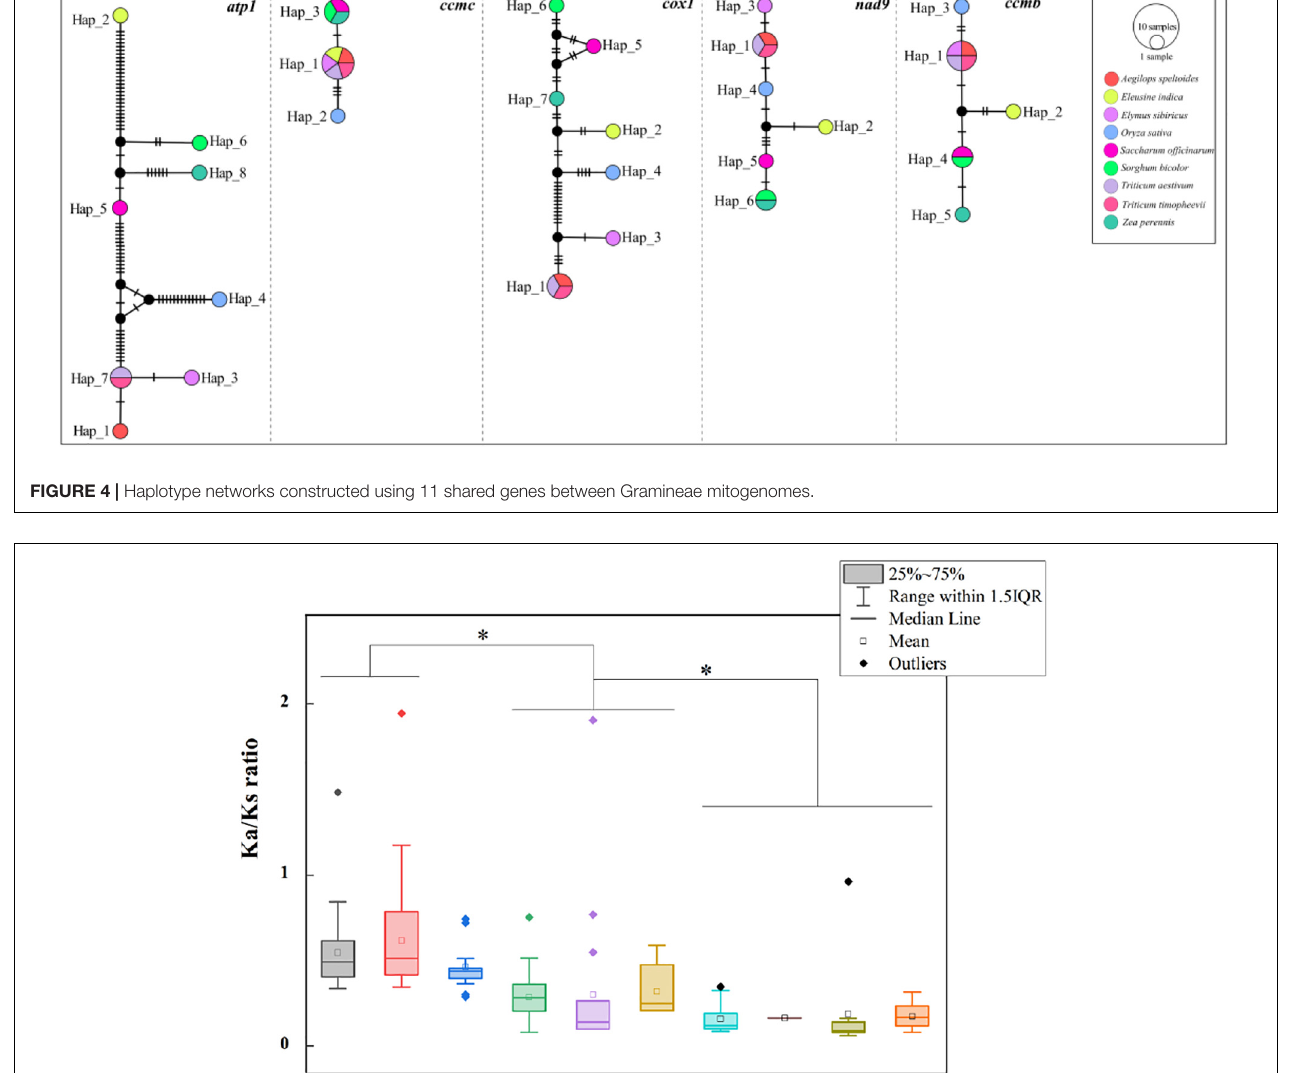
loss, BLAST software was applied to check that the fragments throughout the mitogenomes perfectly matched with the databases of their own corresponding chloroplast genomes